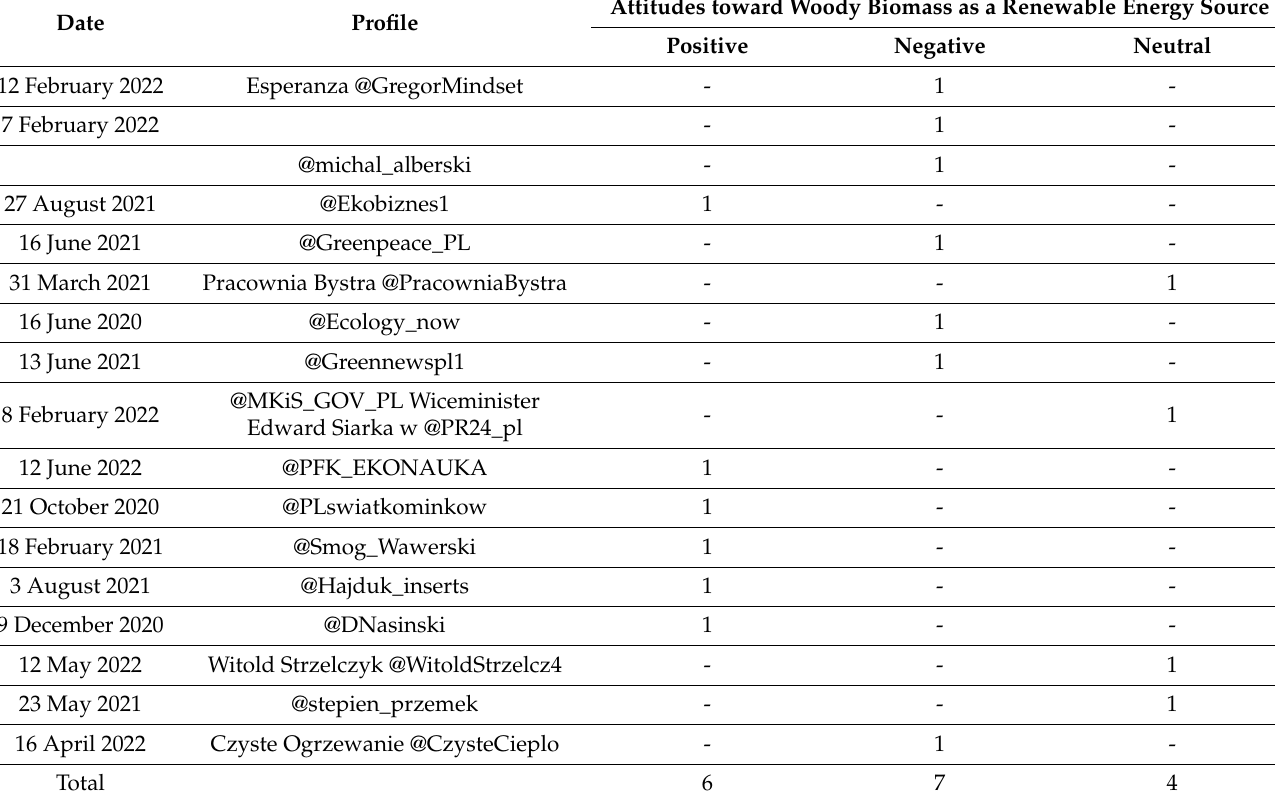
Table 3. Social media 1: Twitter (C) Mode of selection—category: TOP